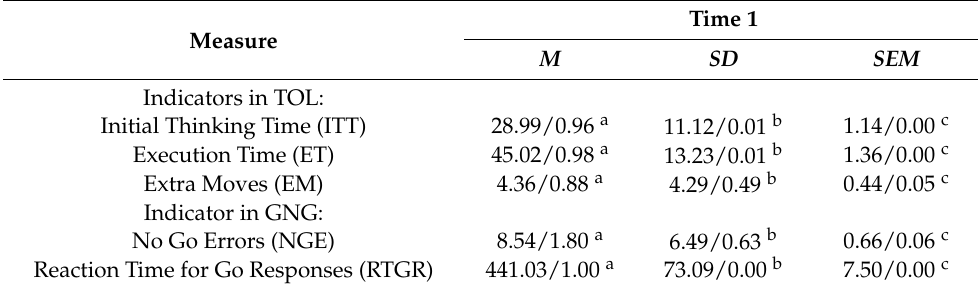
Table 6. Descriptive statistics of performance on Tower of London (TOL) and Go/No Go (GNG) task in first